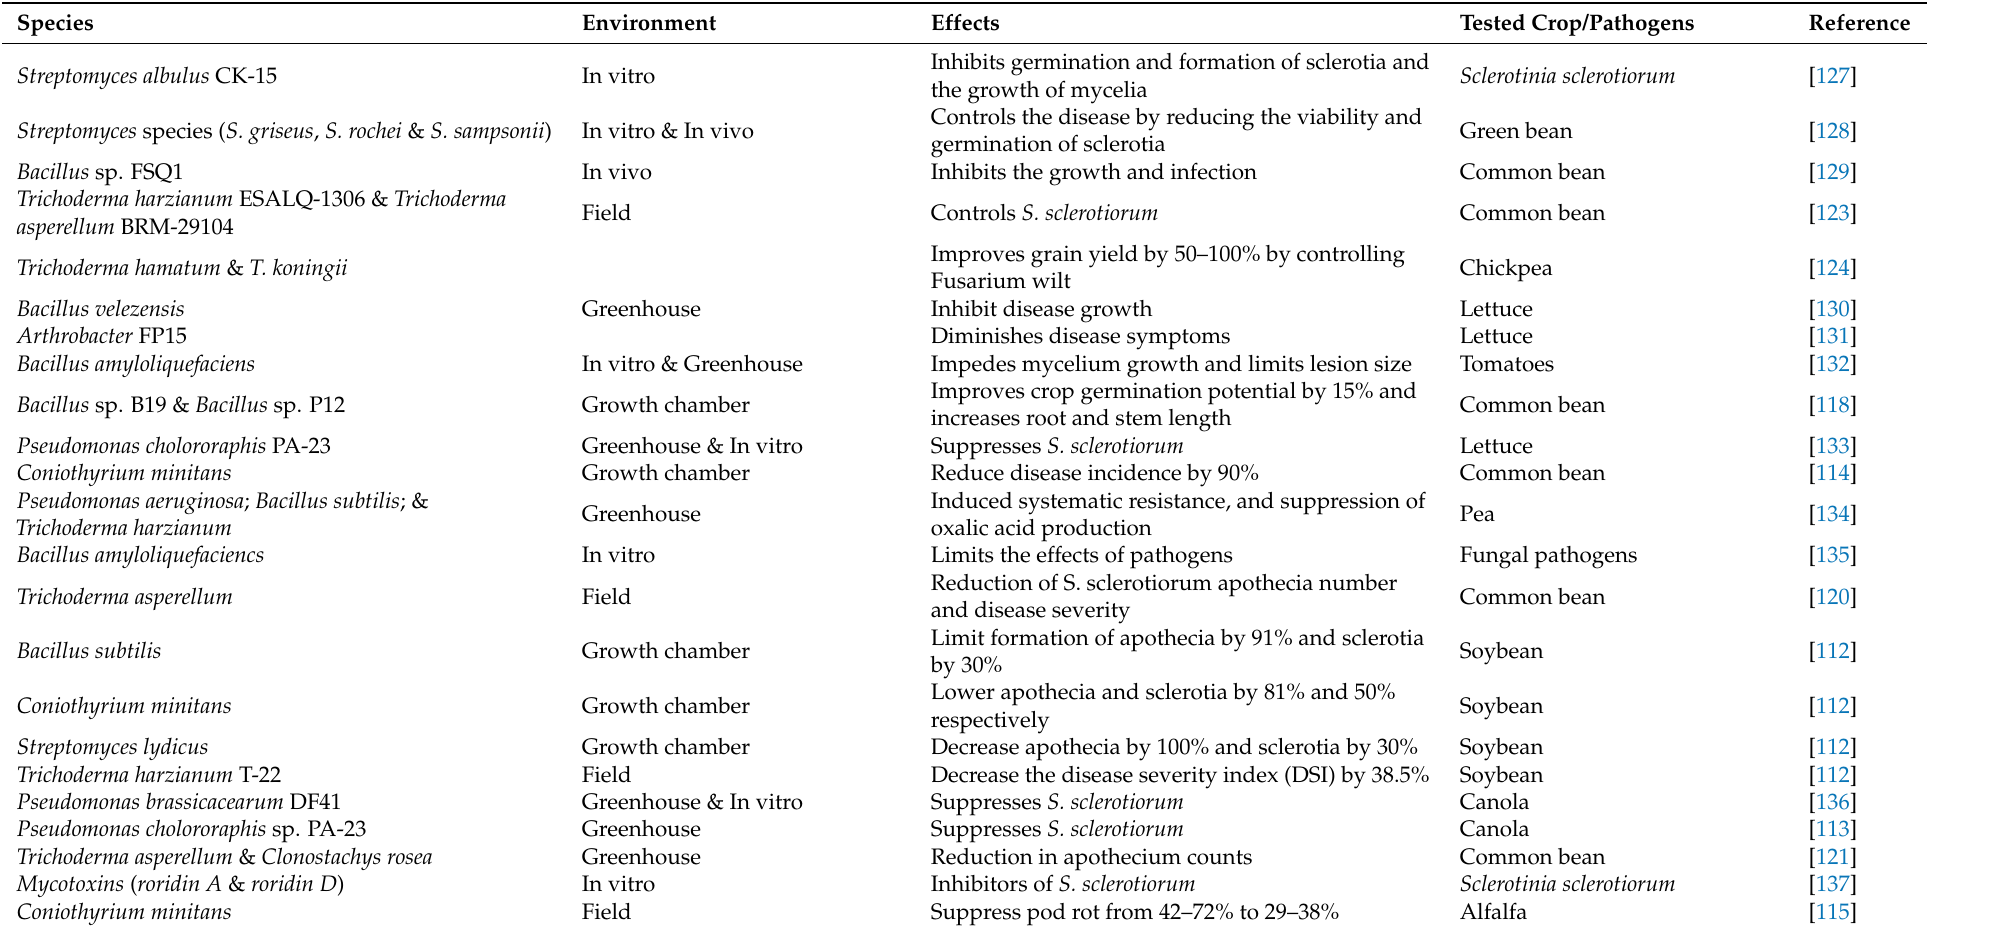
Table 2. Biocontrol agents used in controlling S. sclerotiorum in